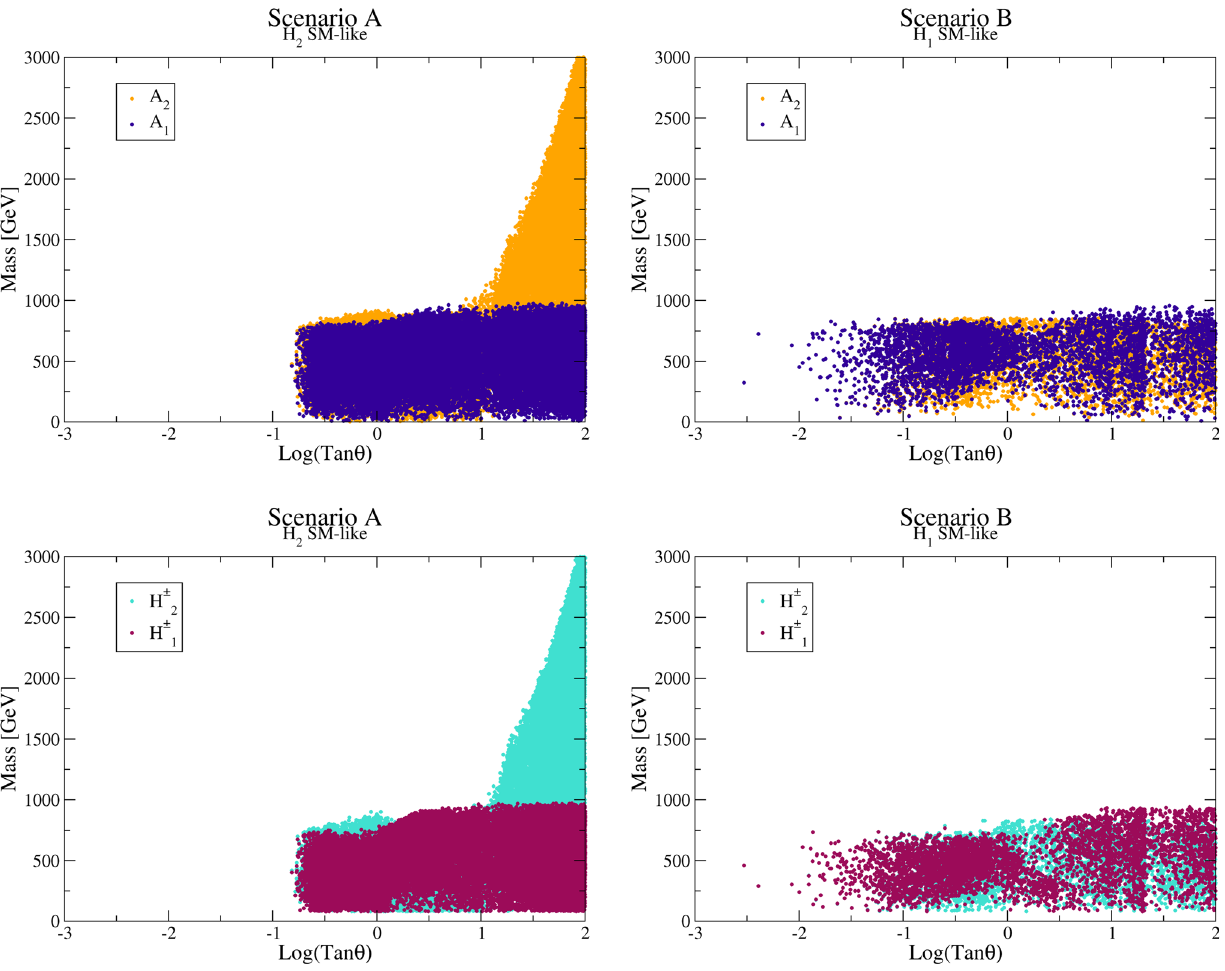
Fig. 3 Dependence of the two pseudoscalar masses m A with the constraints of previous figures plus the bounds on the SM-like Higgs boson mass for each scenario